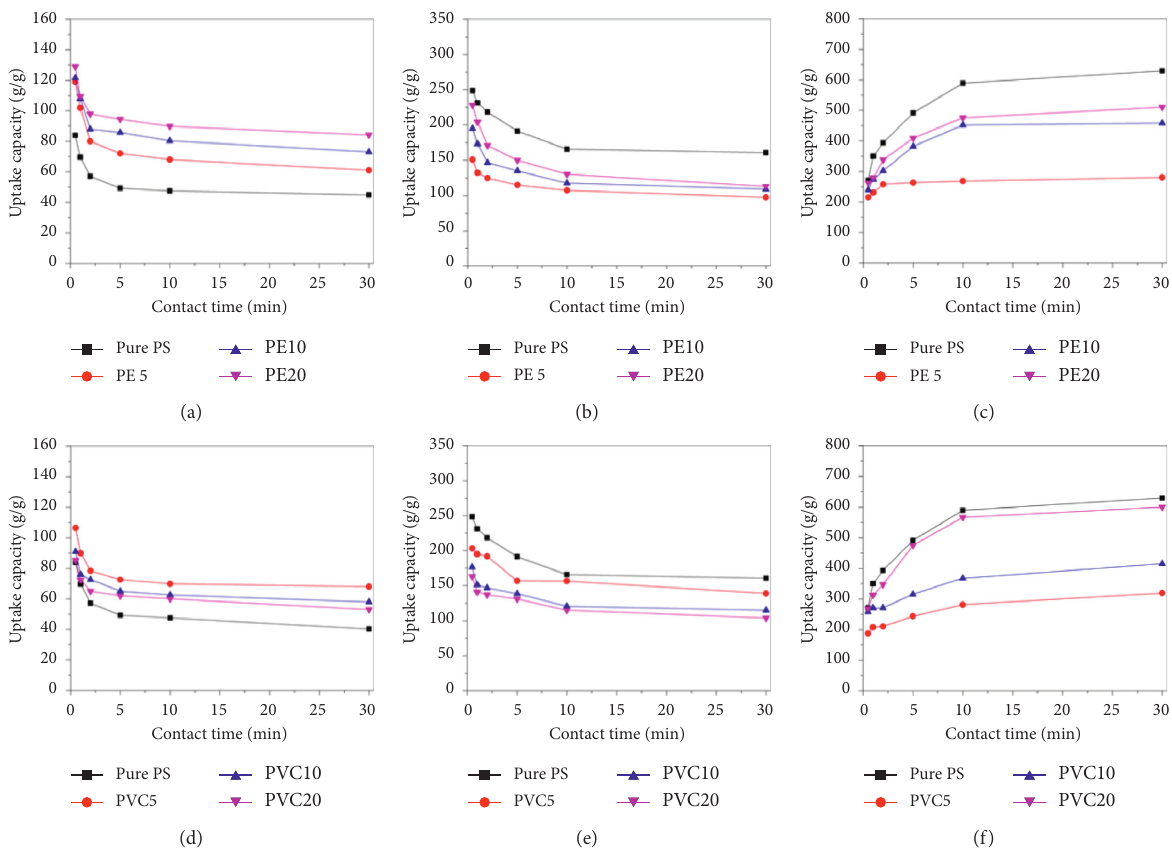
Figure 5: Uptake capacity of PS-PE (a–c) and PS-PVC (d–f) fibrous sorbents to crude oil (a and d), diesel (b and e), and motor oil (c and f) spills.